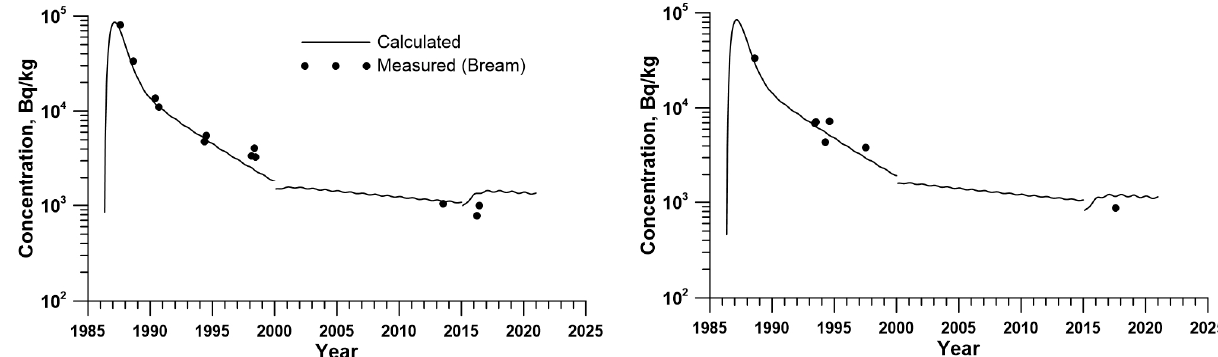
Figure 6. Comparison of calculated and measured concentrations of 137 Cs in demersal fish in Sector 1 ( left ) and Sector 7 ( right ) of the